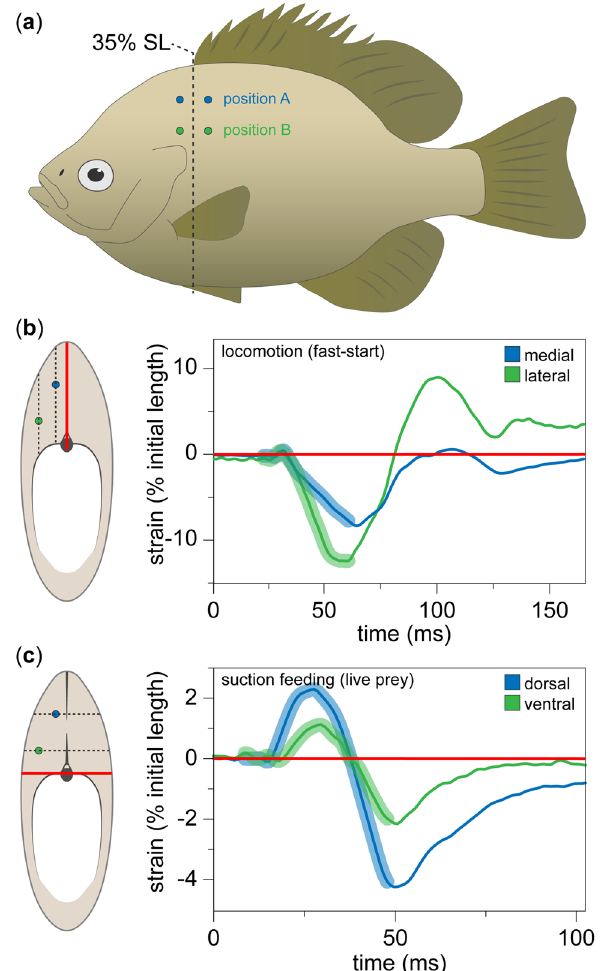
Figure 2. Sonomicrometer implantation sites and in vivo muscle length dynamics. ( a ) Lateral view of the implantation sites for each sonomicrometer pair. ( b ) Epaxial length dynamics during an evasive fast-start alongside a transverse view of sonomicrometer positions relative to the neutral axis of bending (solid red line). In lateral flexion, longitudinal strain is expected to vary as a function of mediolateral distance from the neutral axis, and thus the dorsoventral position of the instrument can be ignored. ( c ) Epaxial length dynamics during a suction feeding on live prey alongside a transverse view of sonomicrometer positions. In dorsiflexion, longitudinal strain is expected to vary as a function of dorsoventral distance from the neutral axis (solid red line), and thus the mediolateral position of the instrument can be ignored. Lengthening before shortening, as shown here, occurred in some but not most feeding strikes. Thick lines indicate the duration of muscle activity (see supplementary Fig. S1 for sample EMG traces). Data shown are from individual